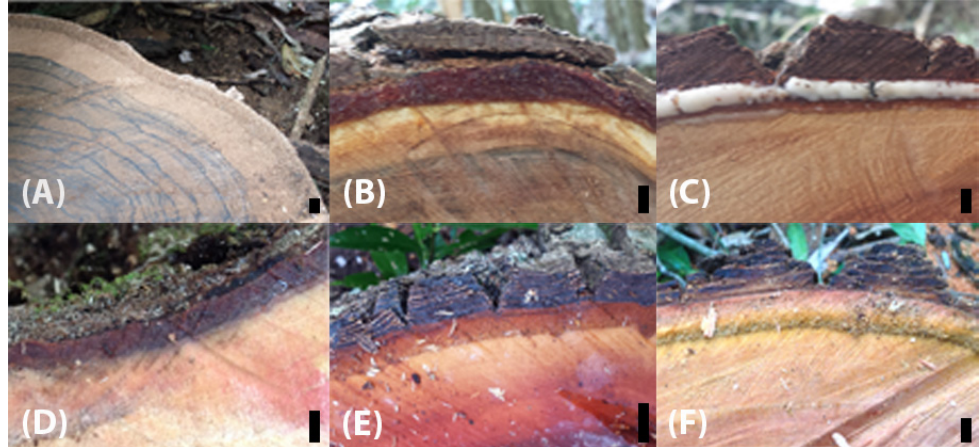
Figure 2. Bark thickness at the level of the stump. ( A ) Cordia dodecandra , with thin bark for its diameter; ( B ) Lysiloma latisiliquum , with thick outer bark that is shed in plates; ( C ) Manilkara zapota, with very thick outer bark and inner bark with the white latex used as a chewing gum base; ( D ) Metopium brownei , with bark that produces a black irritating exudate; ( E ) Swartzia cubensis , with characteristic furrowed bark; and ( F ) Swietenia macrophylla , with very thick bark covering one of the most prized woods of the Mayan rainforests. Scale bar = 5 mm.